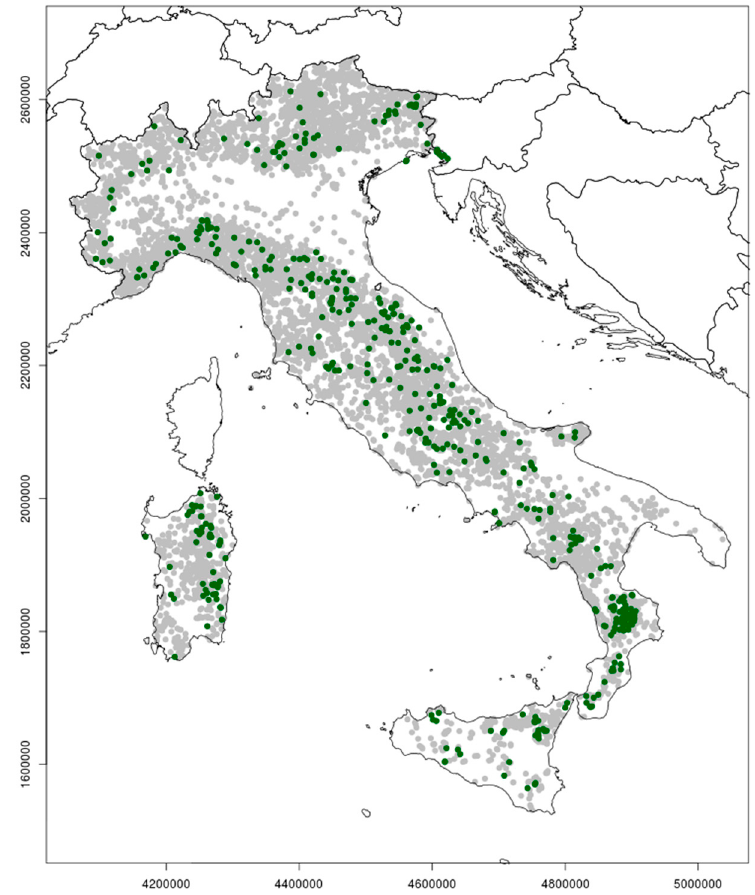
Figure 1. Spatial distribution of all INFC2005 inventory points (all dots) and sampling units which were classified as “Artificial black pine stands” (dark dots) during field activities.